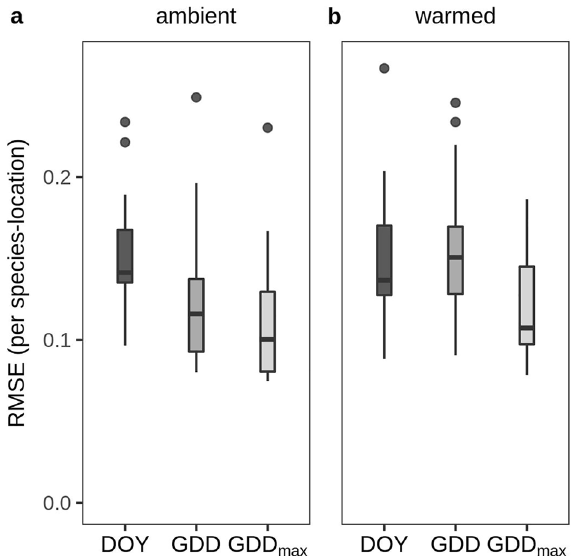
Figure 4. The predictability of flowering. Box-plots compare the utility of models using day of year (DOY), accumulated growing degree days (GDD) or accumulated growing degree days with an estimated maximum temperature threshold GDD max to predict flowering in ambient ( a ) and warmed ( b ) plots. Values represent the root mean squared error (RMSE) calculated for each species at each location based on the difference between the predicted and actual number of flowers in each survey, normalized by the total number of flowers counted in each year. Lower RMSE implies a better model. The maximum temperature thresholds used in the GDD max models were estimated using only observations from plants in ambient conditions; only those species that showed a saturating relationship to temperature are included here (male and female Salix and subspecies were treated as separate